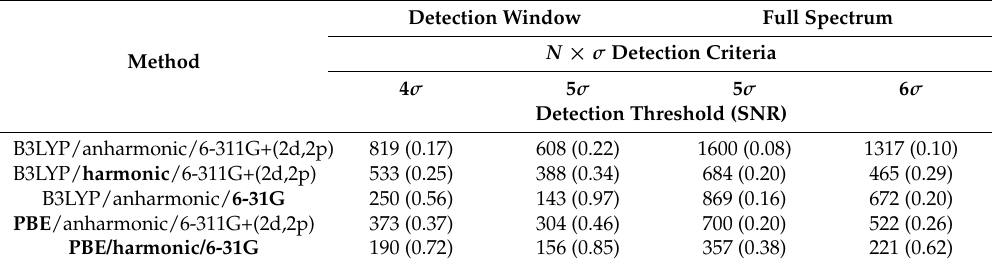
Table 1. Detection levels (noise levels and corresponding SNR values in parentheses) when using spectra computed at different levels of theory to program the filter. The reference spectrum computed at the highest level of theory is used to model the signal deteriorated by noise. Lower level approximations vs. the reference spectrum are highlighted in bold. The results are shown for the most promising peak detection criteria ( N × σ